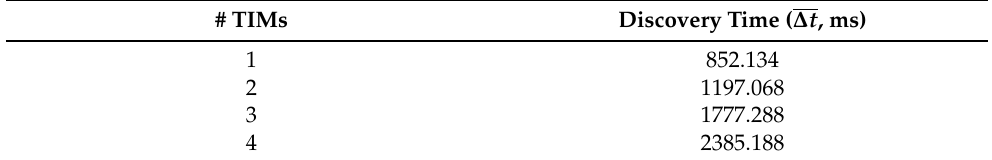
Table 2. Discovery Test—Total Times, n